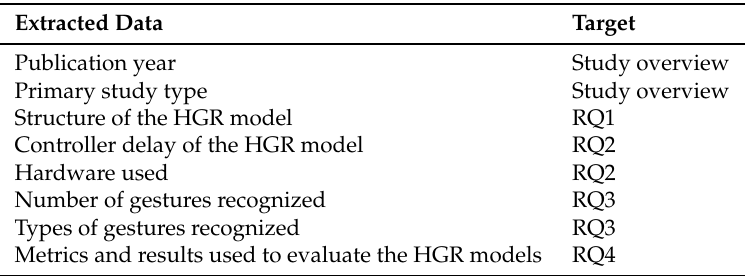
Table 5. The data extracted from the 65 SPS and their